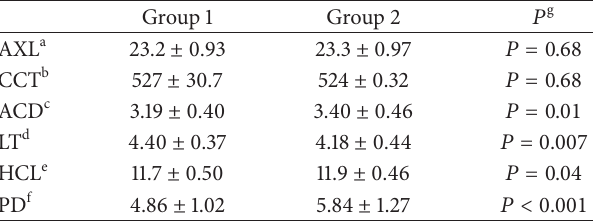
Table 2: Optical low coherence reflectometry findings of patients.